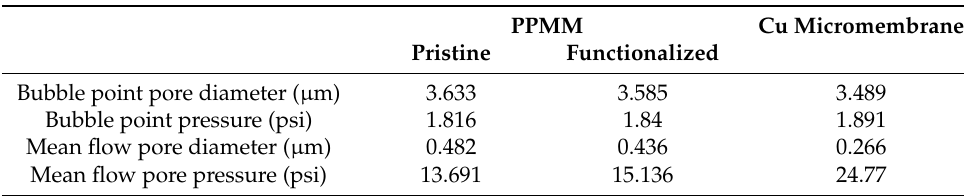
Figure 3. ( a ) The high-resolution SEM image of Cu micromembrane. ( b ) The cross-sectional SEM image of Cu micromembrane at low resolution. ( c ) The photograph of samples in different stages: pristine PPMM, functionalized PPMM, Ag-activated PPMM, and Cu micromembrane. Table 1. Relevant parameters from capillary flow porometer for pristine PPMM, functionalized PPMM, and Cu